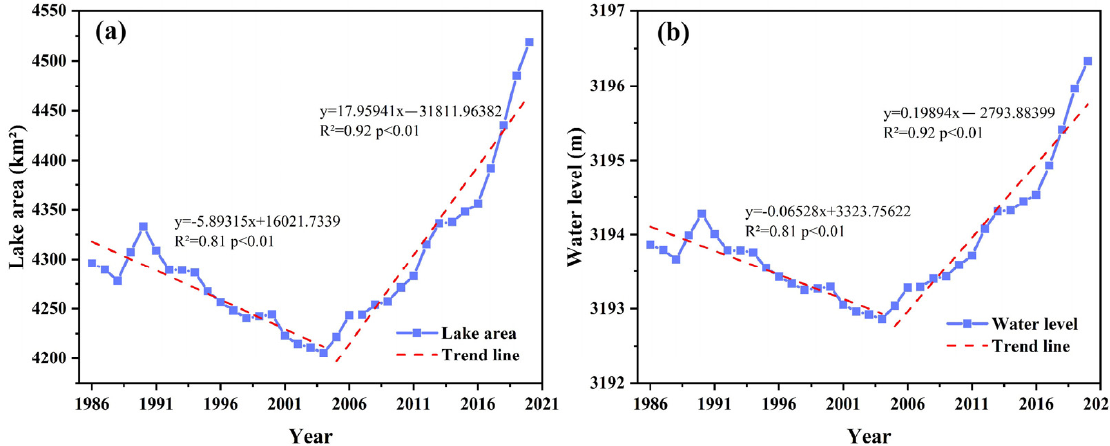
Figure 8. The time series of the lake area and lake level of Lake Qinghai from 1986 to 2020.